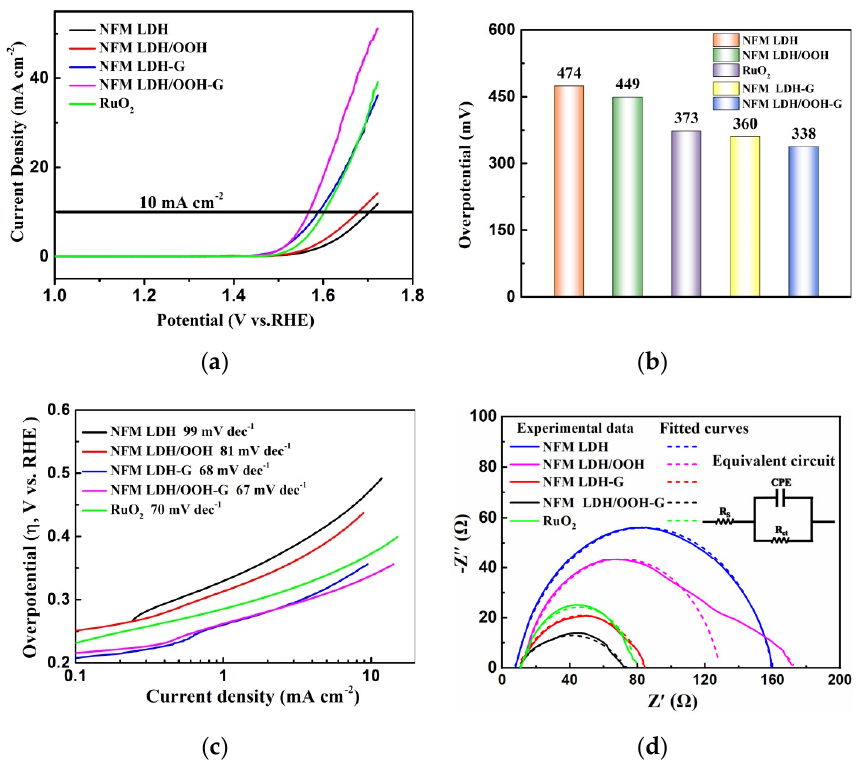
Figure 6. Electrocatalytic performance tests: ( a ) LSV plot; ( b ) Overpotential; ( c ) Tafel slope diagram; ( d ) EIS spectrum (solid lines represent the experimental data and the dashed lines denote the fitted curves).